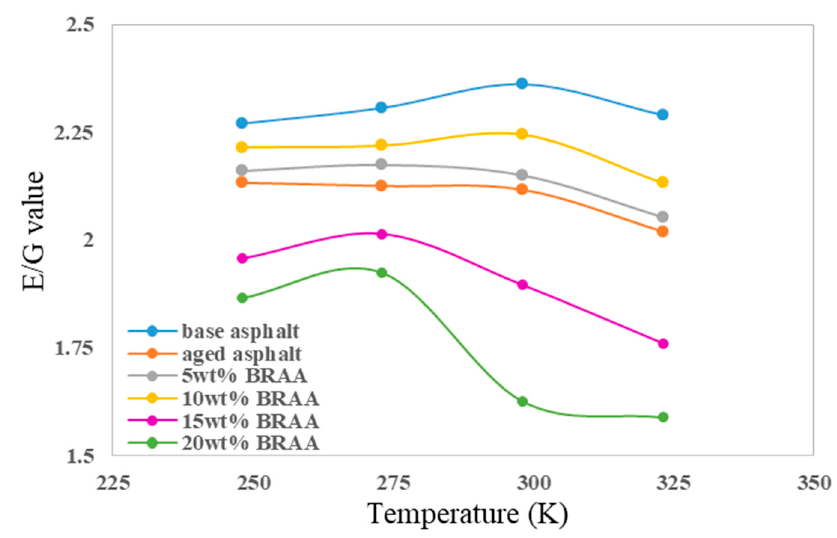
Figure 9. The E/G value of asphalt systems.